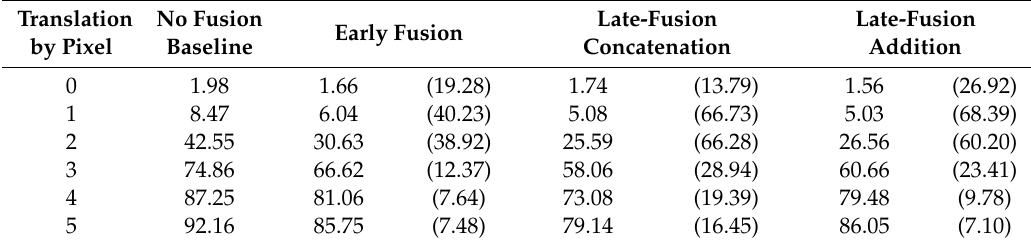
Table 1. Test error rate for a shallow network with a small kernel size (Net-1 with 3 × 3 kernel).